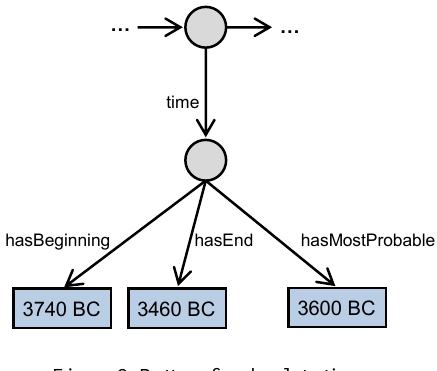
Figure 2. Pattern for absolute time Stratigraphic time is in fact a topological temporal representation (De Roo et al, 2013). In the running example creation of deposit D2 (associated to layer L2) is later than creation of deposit D1 (associated to layer L1) and D2 is above D1.The resulting pattern is shown in Figure 3.